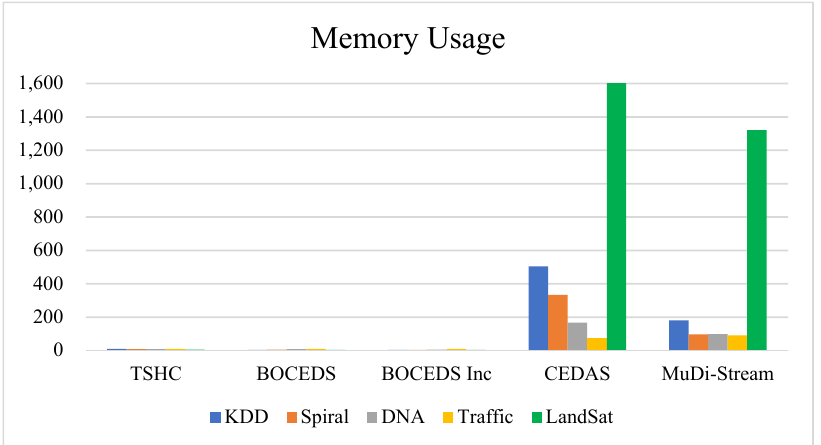
Figure 8. Memory Usage Comparison using KDDCup’99, Landsat, Spiral, DNA, and Traffic Da- tasets.